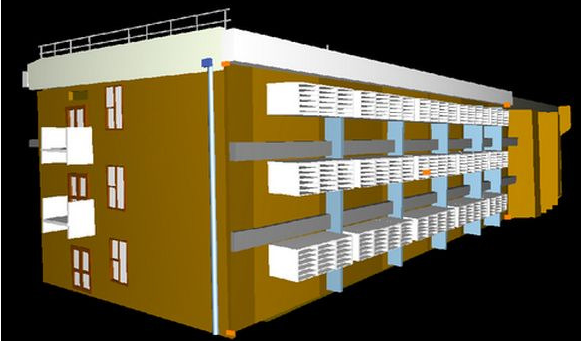
Figure 6: Building Model of previous shown 3D point cloud data sets.